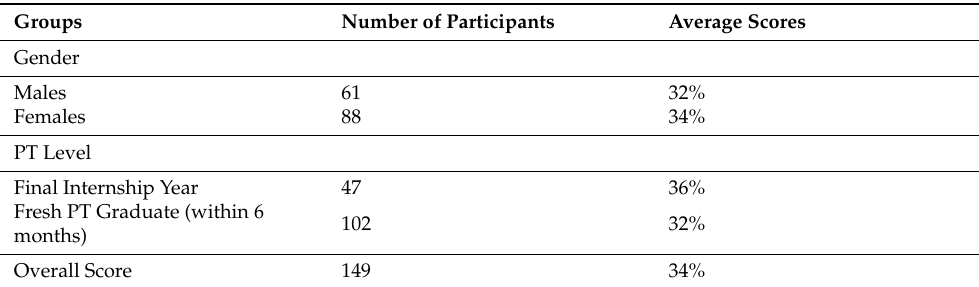
Table 1. Participants’ demographics and examination scores by different characteristics.